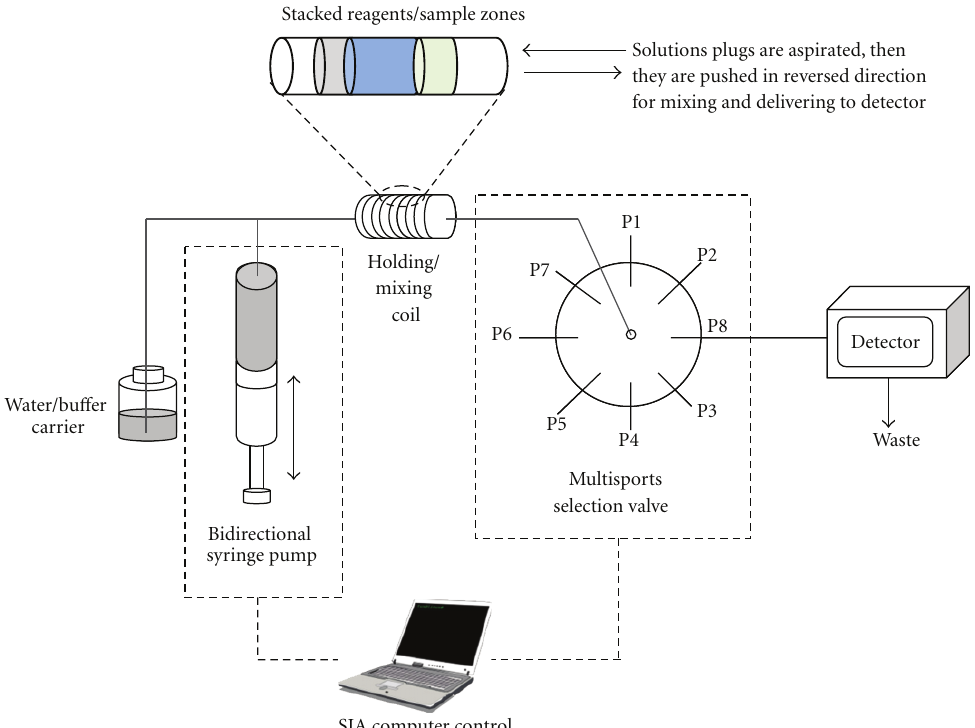
Figure 3: Diagram of a sequential injection analysis system (not to scale). P1–8 are ports on a multiports selection valve for transportation of various